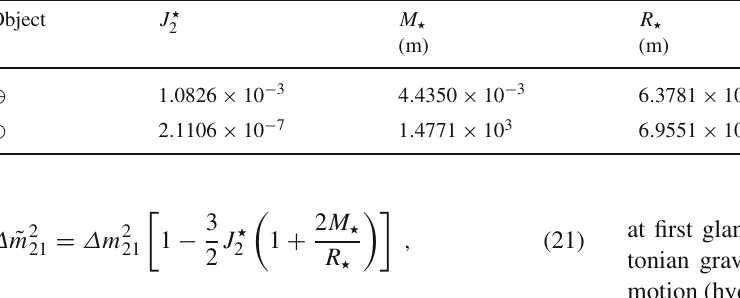
, and the percent departure from object, the inferred value of Δ m 2 21